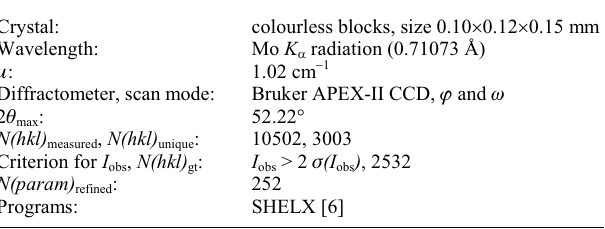
Table 1. Data collection and handling.